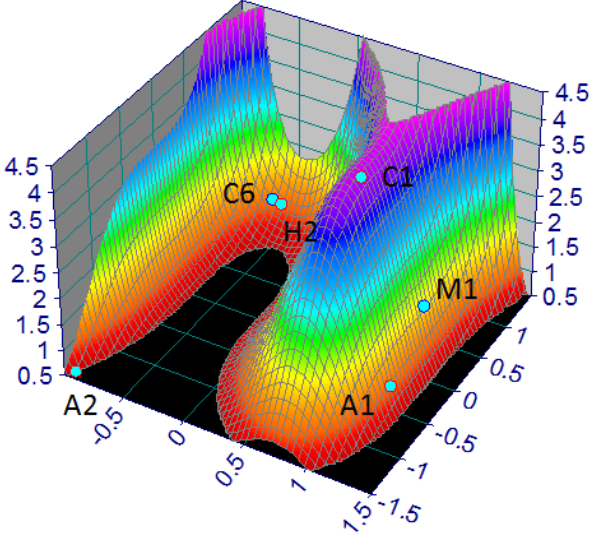
Figure 7. Prediction of SSR drawdown of Murgia and Salento groundwater for 2050 owing to the increases in groundwater temperature of up to 2 ◦ C and conductance of up to 0.04 mS/cm.